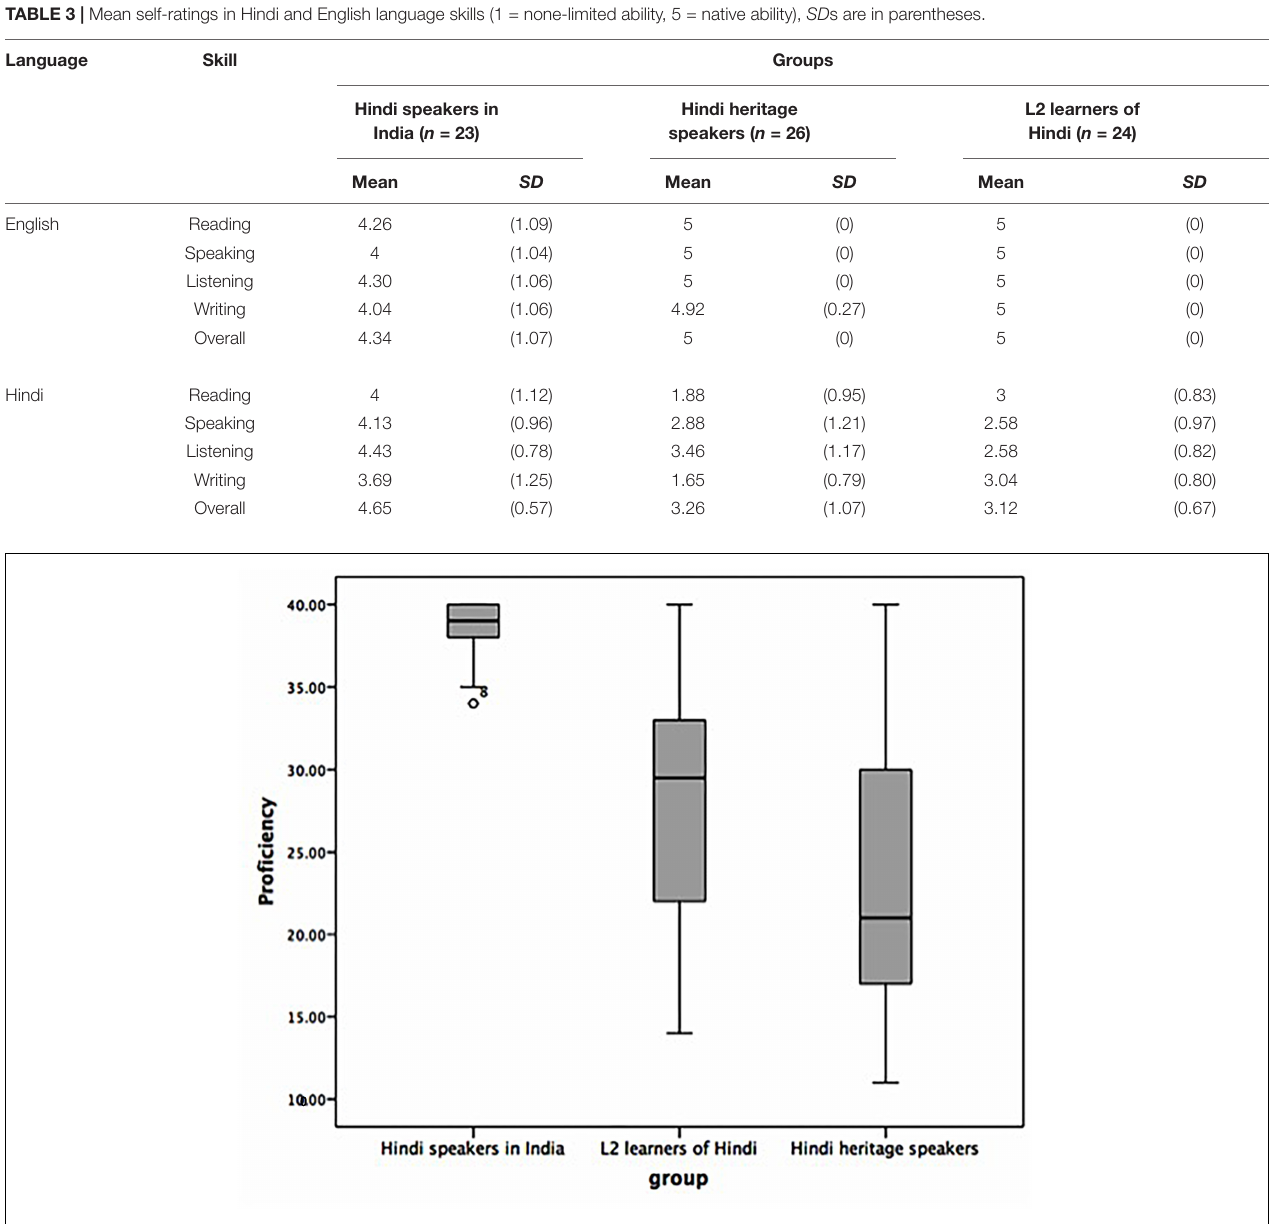
FIGURE 2 | Mean distribution of scores in the written Hindi proficiency cloze